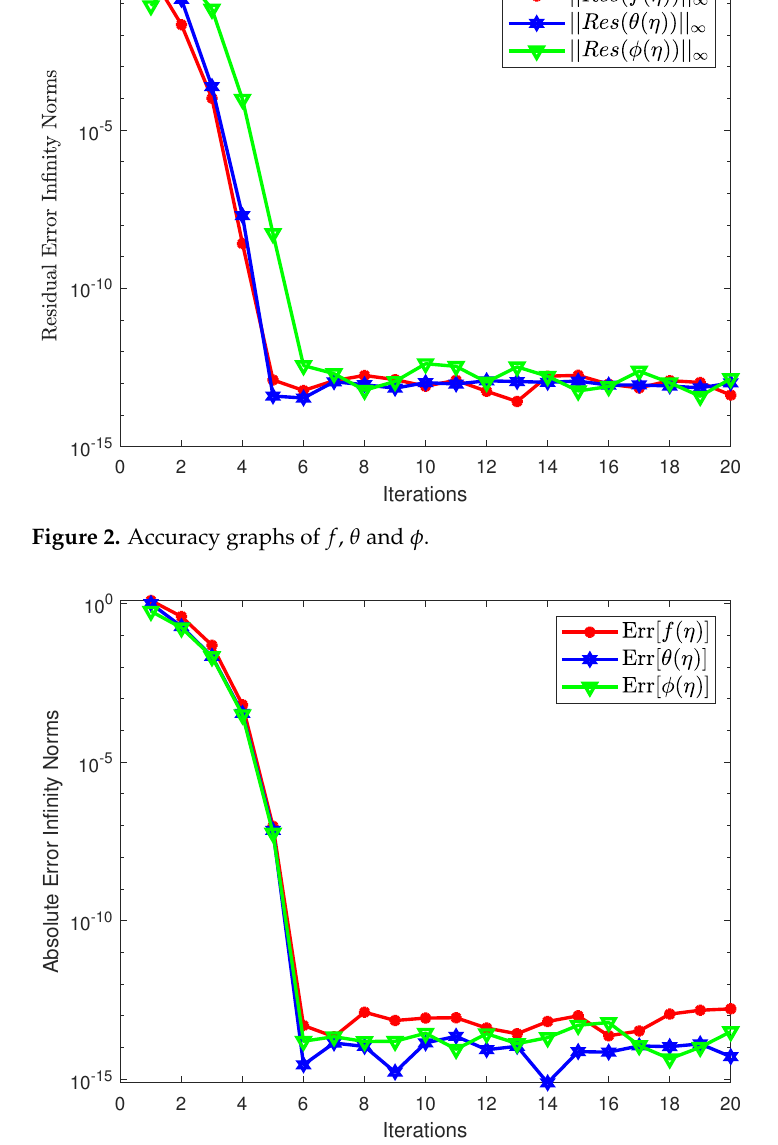
Figure 3. Convergence graphs of f , θ and φ